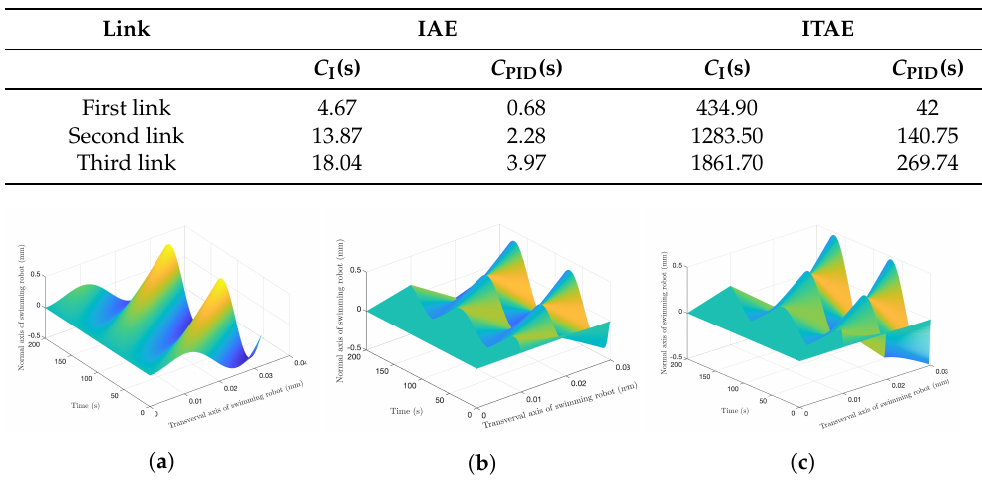
Figure 13. Three-dimensional representation of non-reciprocal motion for: ( a ) ideal waveform, ( b ) simulated motion with C PID ( s ) , ( c ) simulated motion with C ∗